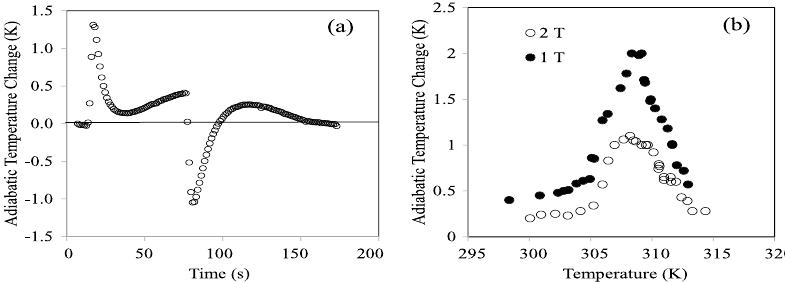
Figure 11. Direct measurements of the adiabatic temperature changes performed ( a ) during compressive loading and unloading at 310 K up to 100 MPa (strain rate of under magnetic field up to 1 and 2